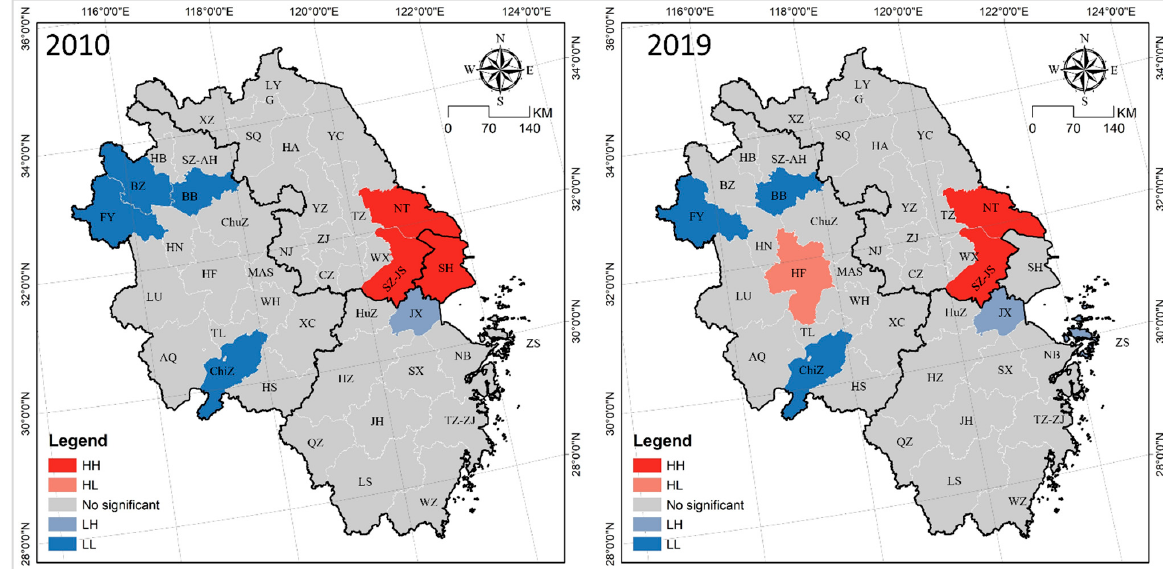
Figure 7. Spatial cluster analysis of urban industrial land in the YRD.